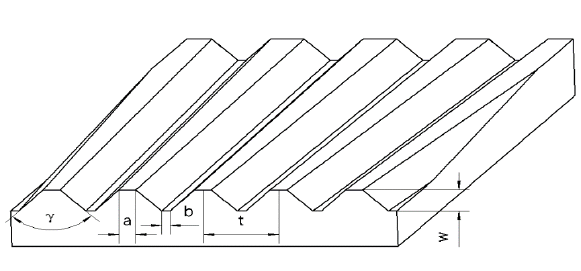
Figure 2: Crushing plate profile dimensions: t - pitch, distance between teeth, w - teeth height, a - crushing surface width, g - teeth walls inclination angle, b - width of the bottom of teeth